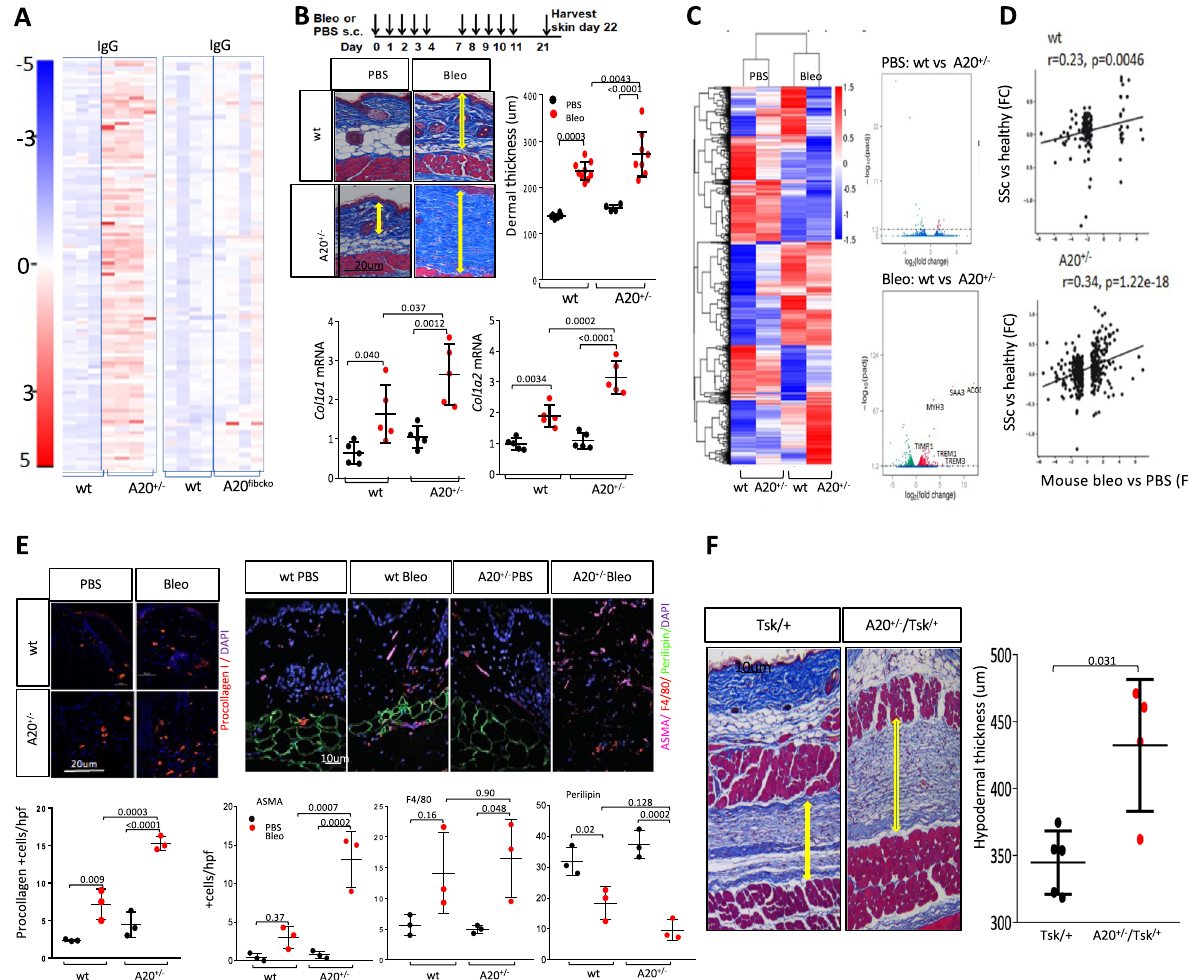
Fig. 2 | Exaggerated skin fi brosis in A20 +/ − mice. A20 fl / fl mice and A20 +/ − mice in parallelweretreatedwiths.c.bleomycin(5mg/kg)for2weeksandsacri fi cedonday 22. A Serum autoantibodies were examined using autoantigen arrays. Heatmap showing -fold change compared with the average in control samples. Heatmap of 112 IgG autoantibodies after fi ltered by SNR >3% across all samples. Red, upregu- lated; blue, downregulated. FDR=0.05. B Top: schematic of the experiment. Left upper panels: lesional skin, Trichrome stain. Representative images. Bar=20 µ m. Arrows indicate dermis. Right upper panel: quantitation of dermis thickness (mean±SD of eight determinations/hpf, A20 fl / fl PBS, n =6, Bleo, n =9; A20 +/ − , PBS, n =4, bleo, n =8). One-way analysis of variance followed by Sidak ’ s multiple com- parisontest.Lowerpanels:qPCRofskinRNA.Results,normalizedwithGAPDH,are mean±SD of triplicate determinations from three mice/group. One-way ANOVA followed by Sidak ’ s multiple comparison test. C Skin transcriptome analysis. RNA isolated from the lesional skin was hybridized to Illumina human HT12 Microarray Chips.Leftpanel:heatmapshowing-foldchangeingeneexpressioncomparedwith the average in controls. Red, upregulated; blue, downregulated. FDR, 0.05, >1.5- fold change. Clusters indicate genes with expression signi fi cantly up- or